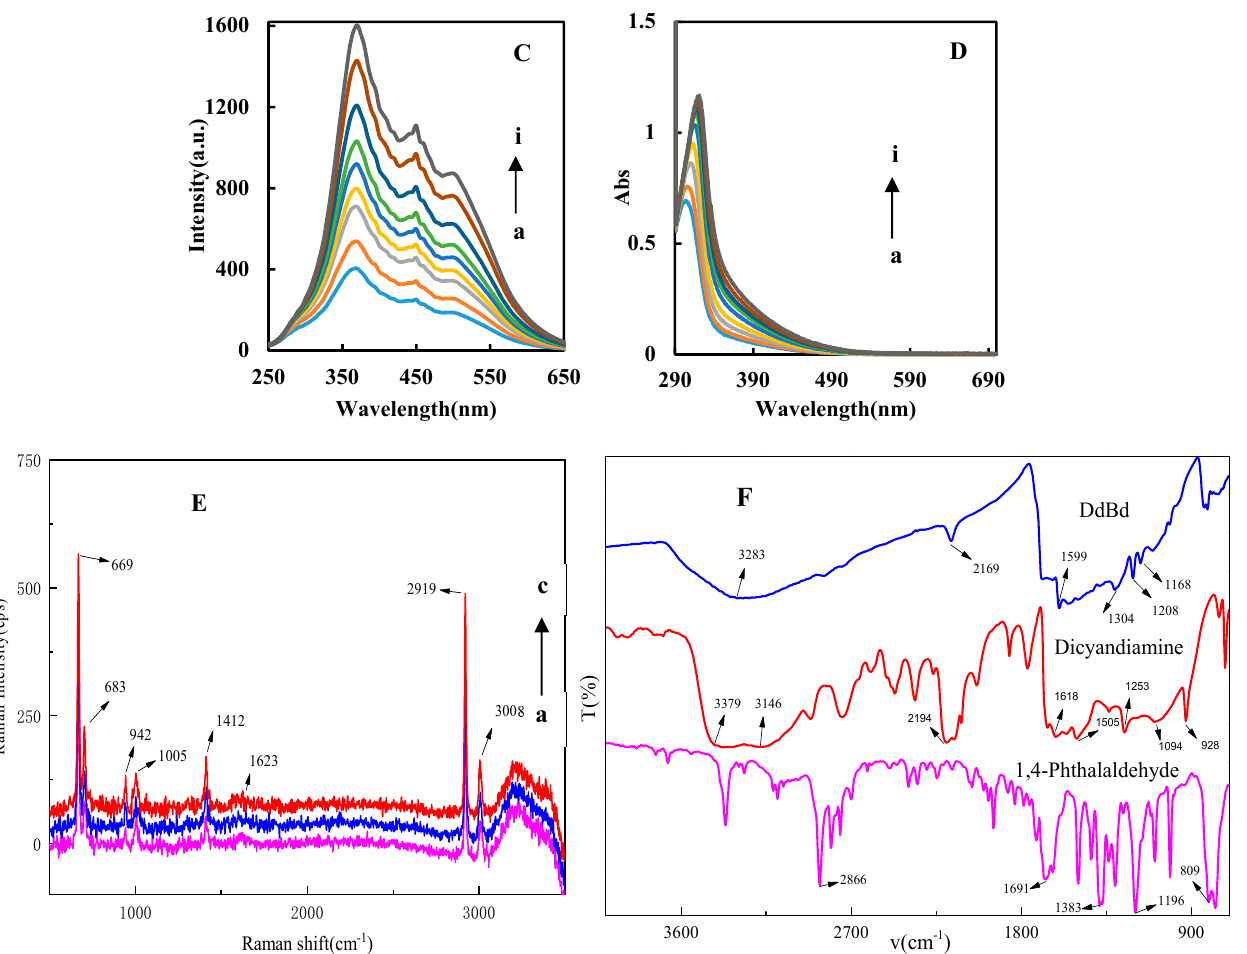
Figure A1. Molecular spectra of DdBd. ( A ) Fluorescence spectrum of DdBd (a–i: 10.7, 11.8, 12.5, 13.2, 15.0, 17.3, 18.8, 20.5, 22.5 mmol/L DdBd, with volt = 500 V, excited slit = emission slit = 5 nm). ( B ) Fluorescence spectrum of 0.680 mmol/L DdBd+Apt OTC (a–d: 0, 20.0, 40.0, 50.0 nmol/L Apt OTC , with volt = 500 V, excited slit = emission slit = 10 nm). ( C ) RRS spectrum of DdBd (a–i: 2.25, 3.21, 4.09, 4.89, 5.63, 6.30, 6.92, 7.50, 8.04 mmol/L DdBd). ( D ) Absorption spectrum of DdBd (a–i: 2.25, 2.74, 3.66, 4.29, 5.08, 6.46, 7.07, 7.50, 8.04 mmol/L DdBd). ( E ) Normal Raman spectrum (a–c: 14.5, 17.6, 22.5 mmol/L DdBd). ( F ) FTIR spectrum of dicyandiamide, p-benzaldehyde, and DdBd. Table A1. Comparison of DdBd nanocatalysis characteristics of glycol/PEG systems. Nano Catalytic